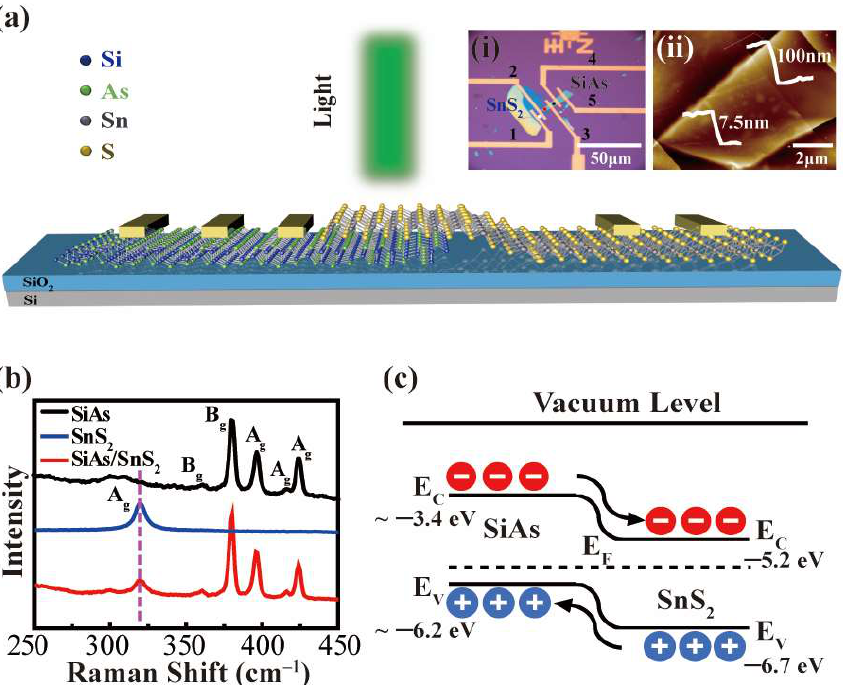
Figure 5. ( a ) Schematic diagram of SiAs/SnS 2 heterojunction device configuration. Inset: (i) Optical image of a typically fabricated device. (ii) Typical AFM images of 2/3 electrode pair. ( b ) Raman characterization results at different positions in the inset of ( a ). ( c ) Schematic band bending diagram and photoexcited carriers transport the SiAs/SnS 2 heterostructures.